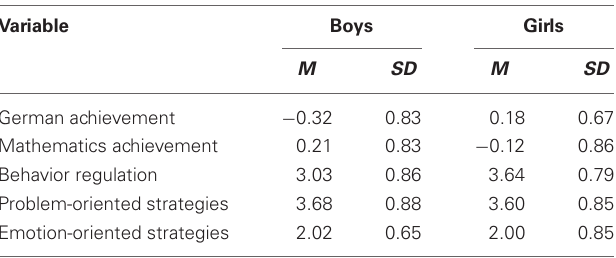
Table 3 | Summary statistics for school achievement and self-regulation